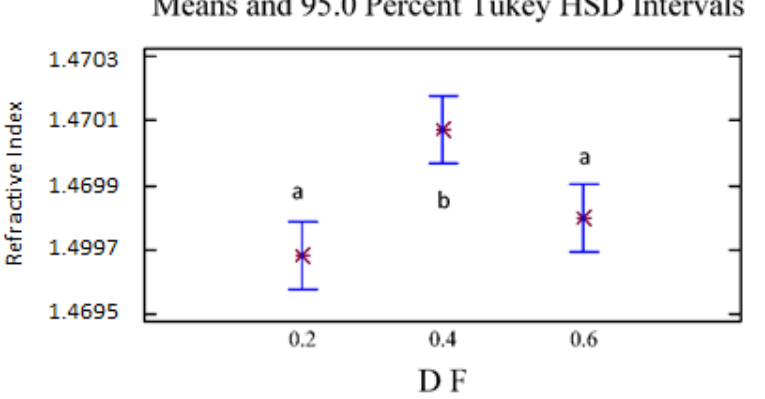
Figure 6. Refractive Index vs. D/F. The results are the average of three replicates ± standard deviation. Different letters over a column indicate statistical differences (Tukey, p < 0.05).